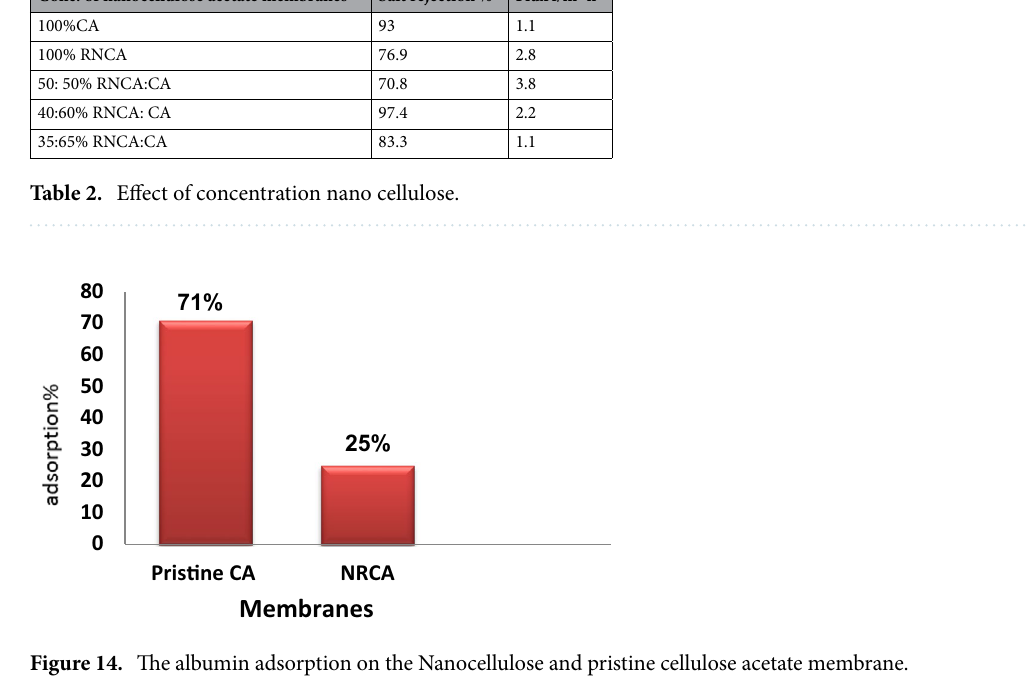
Conc. of nanocellulose acetate membranes